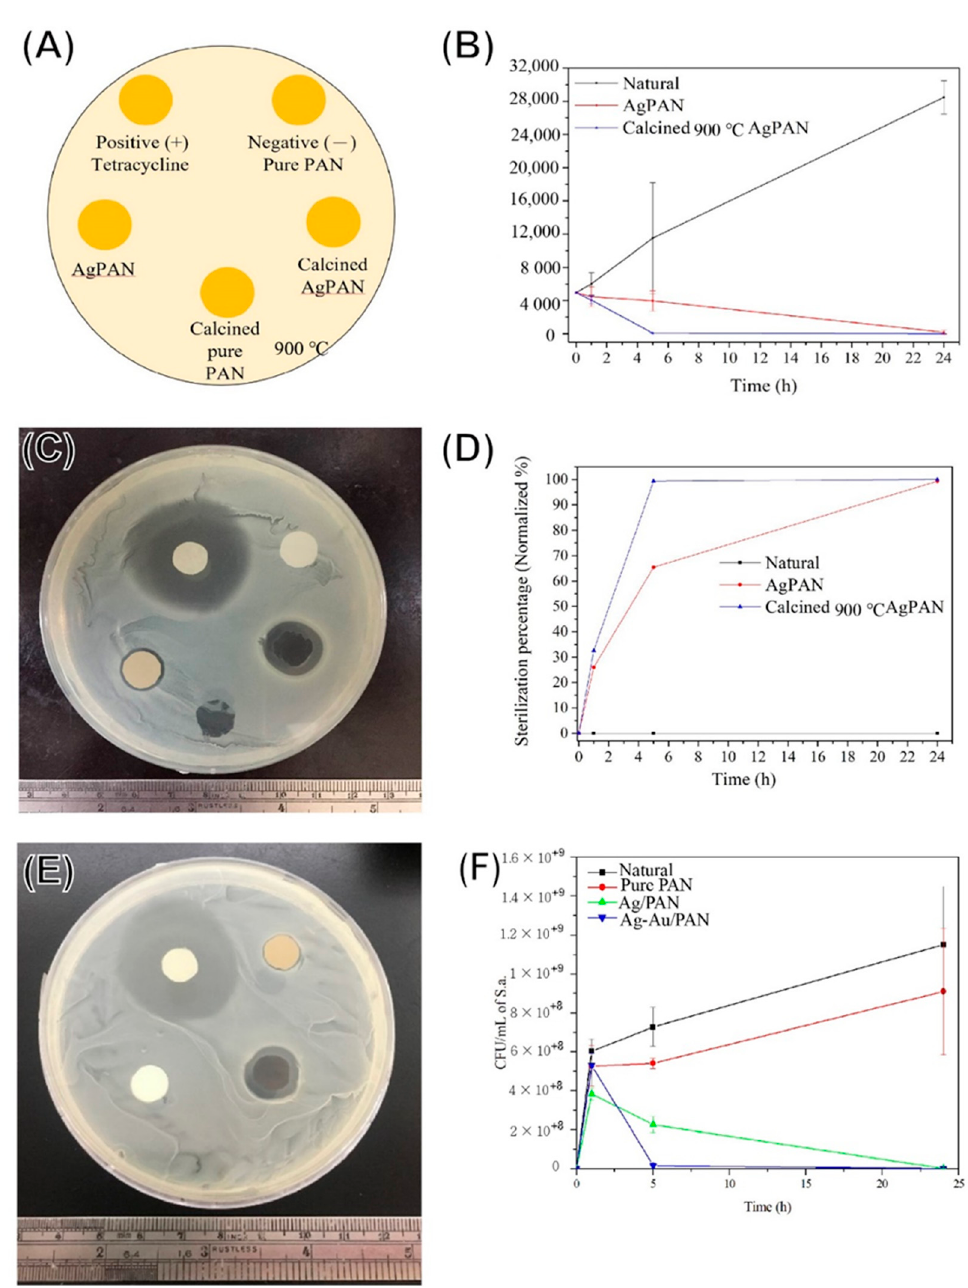
Figure 5. Antibacterial effect of PAN composites on the basis of the inhibition zone test and sterilization rate test. ( A ) Sample schematic illustration; ( B ) bacterial colonies numbers after being treated of different Ag/PAN composites; ( C ) qualitatively inhibition zone results of calcined Ag/PAN; ( D ) quantitively sterilization rate of ( B ) after being normalized to control group; ( E ) qualitative inhibition zone results of urchin-like Ag–Au/PAN nonwoven mats and ( F ) quantitive sterilization rate of urchin-like Ag–Au/PAN nonwoven mats.